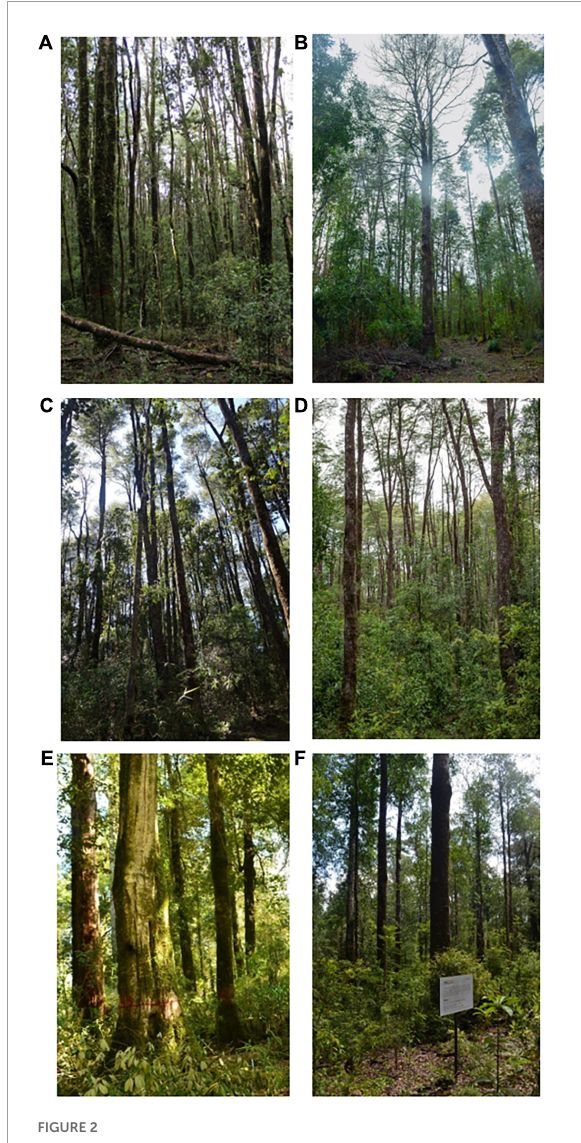
FIGURE2 Studied forests before (left) and 7–10 years after management (right) for variable-density thinning, irregular shelterwood and single-tree selection cuts. The forest with variable-density thinning (A,B) included girdling trees to become dead standing trees like the one in front within the thinned matrix. The forest with irregular shelterwood (C,D) has had a vigorous growth of the advanced and new regeneration. The forest with selection cut (E,F) resulted in a balance between trees of different sizes and abundant